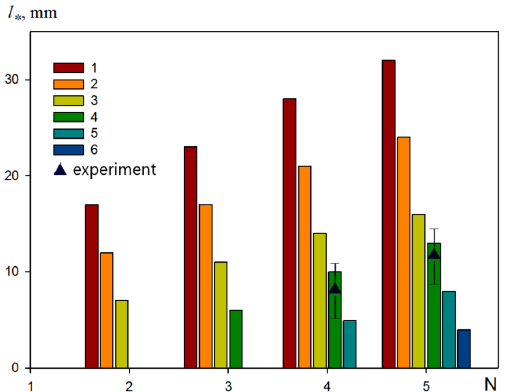
Figure 16. Critical distance between firebrands: 𝐻 = 5 mm, 𝐷 = 5 mm, 𝟏 – 𝐿 = 70 mm, 𝟐 – 𝐿 = 60 mm, 𝟑 – 𝐿 = 50 mm, 𝟒 – 𝐿 = 40 mm, 𝟓 – 𝐿 = 30 mm, 𝟔 – 𝐿 = 20